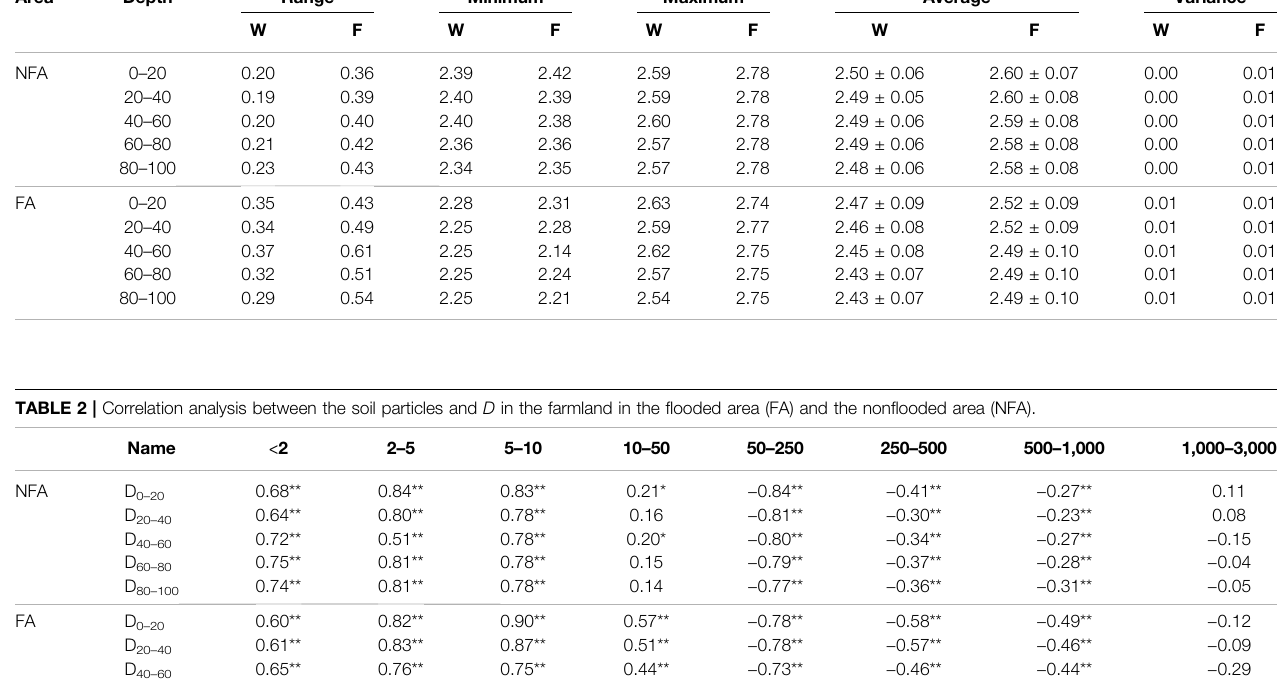
TABLE 1 | D statistical characteristic of the particles in the woodland (W) and farmland (F) in the fl ooded area (FA) and the non fl ooded area (NFA). Area